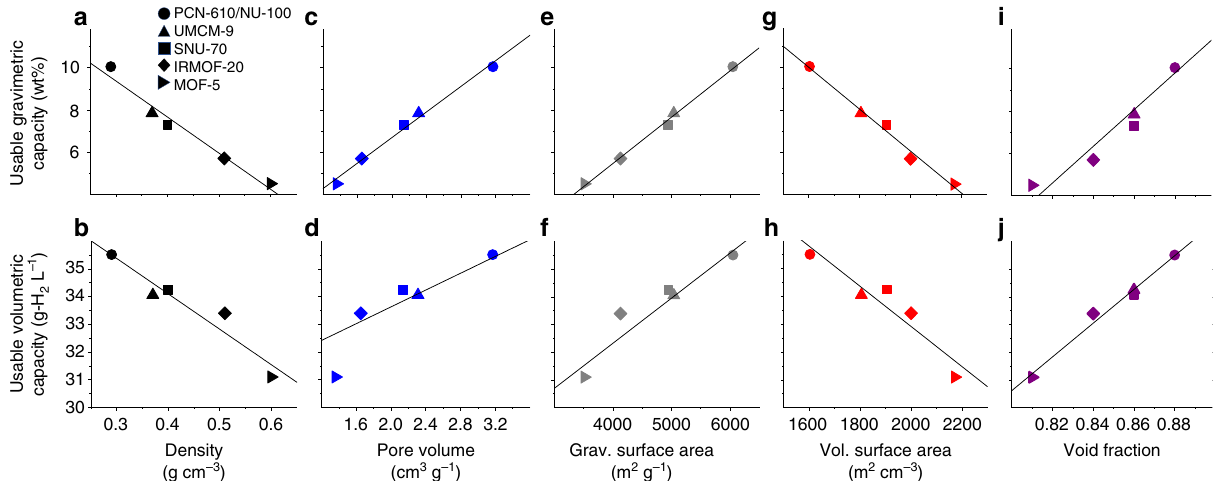
Fig. 5 Relationship between fi ve crystallographic properties and the usable capacities of the highest-capacity MOFs examined in the present study. Capacities are evaluated assuming an isothermal pressure swing between 5 and 100 bar at 77 K. ( a , c , e , g , i ) usable gravimetric capacities, ( b , d , f , h , j ) usable volumetric capacities